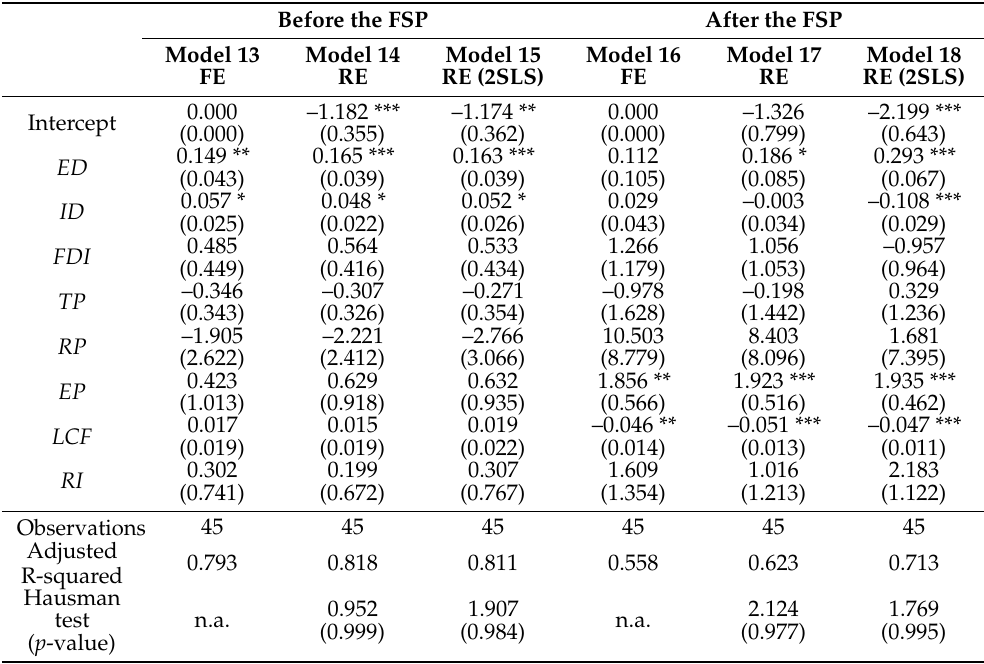
Table 4. Panel data regression results (fixed-effects (FE) and random-effects (RE)) and two-stage least squares (RE (2SLS)) estimation for Central China.